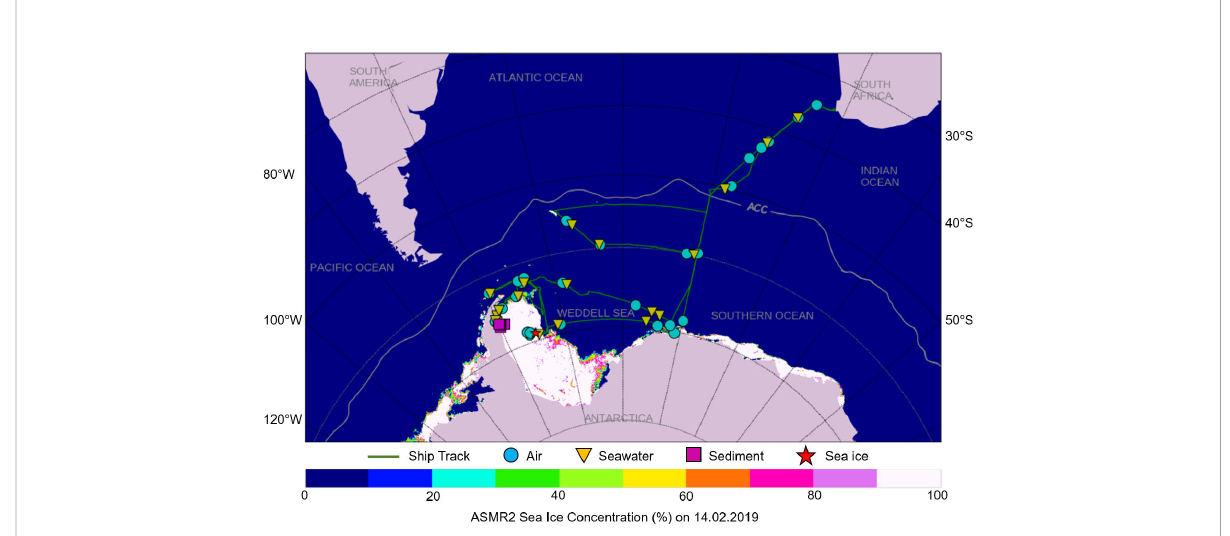
FIGURE 1 The ship track of the R/V SA Agulhas II and sampling locations for air, seawater, sediment, and sea ice during the ‘ Weddell Sea Expedition 2019 ’